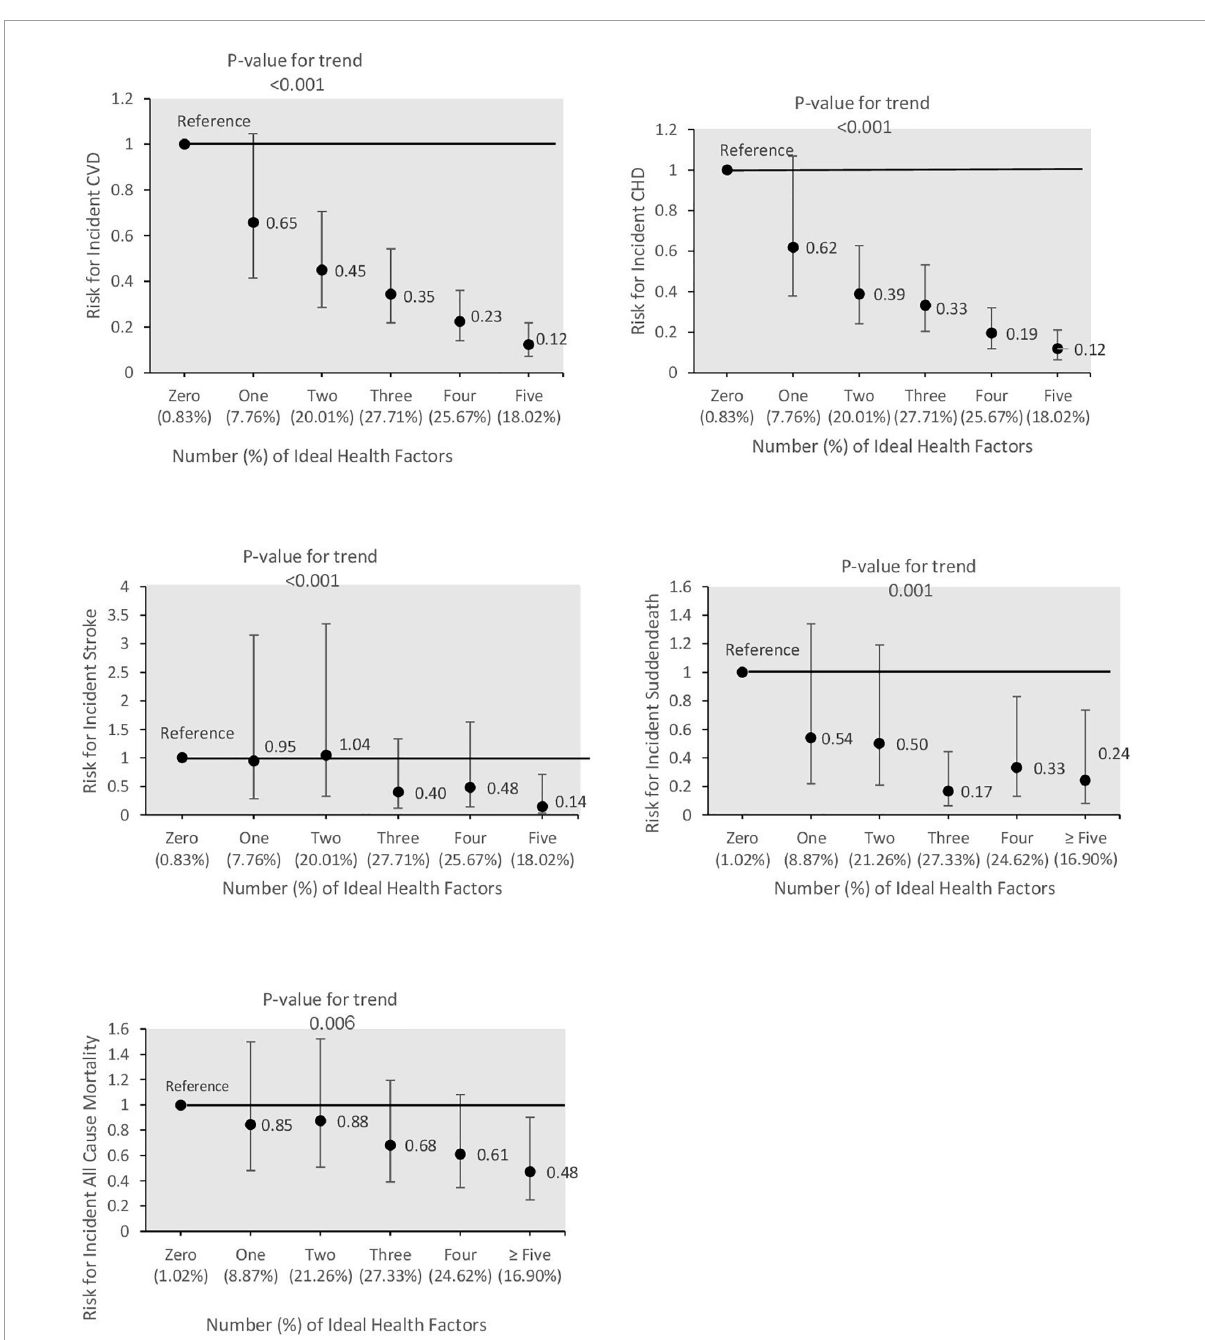
FIGURE1 Hazard ratios (95% CI) of cardiovascular disease and its subtypes including coronary heart disease (CHD), stroke and sudden death, and all-cause mortality events according to combined ideal cardiovascular health metrics; Tehran Lipid and Glucose Study, 2005–20018. Hazard ratios adjusted for sex and age, educational level, marital status, family history of CVD, and prevalent CVD (for all-cause